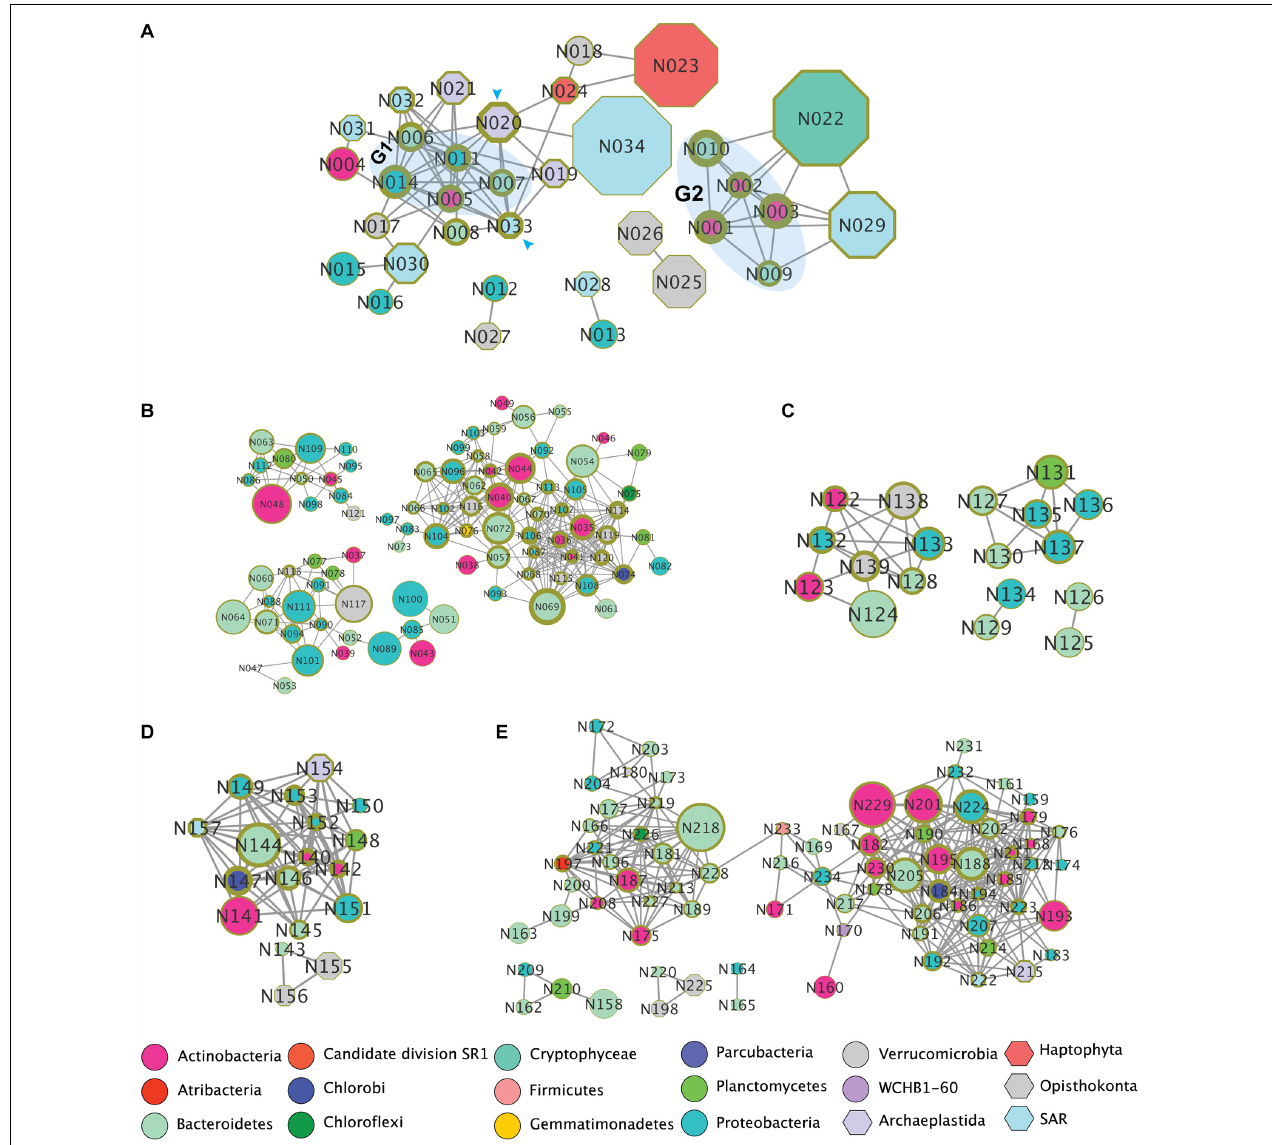
FIGURE 6 | Co-occurrence patterns of OTUs in Lakes Bonney and Fryxell based on pairwise Pearson correlation coefficient between samples. (A) Co-occurrence between Eukarya and Bacteria in Lake Bonney. (B) Bacteria in Lake Bonney oxic zone. (C) Bacteria in Lake Bonney Anoxic zone. (D) Co-occurrence between Eukarya and Bacteria in Lake Fryxell. (E) All bacterial OTUs in Lake Fryxell. Nodes represent individual OTUs. Node colors represent phyla. The size of each node represents relative abundance of the corresponding OTU. Thickness of the circle outside each note indicates number of edges of corresponding note. Taxonomies of nodes were summarized in Supplementary Table S3